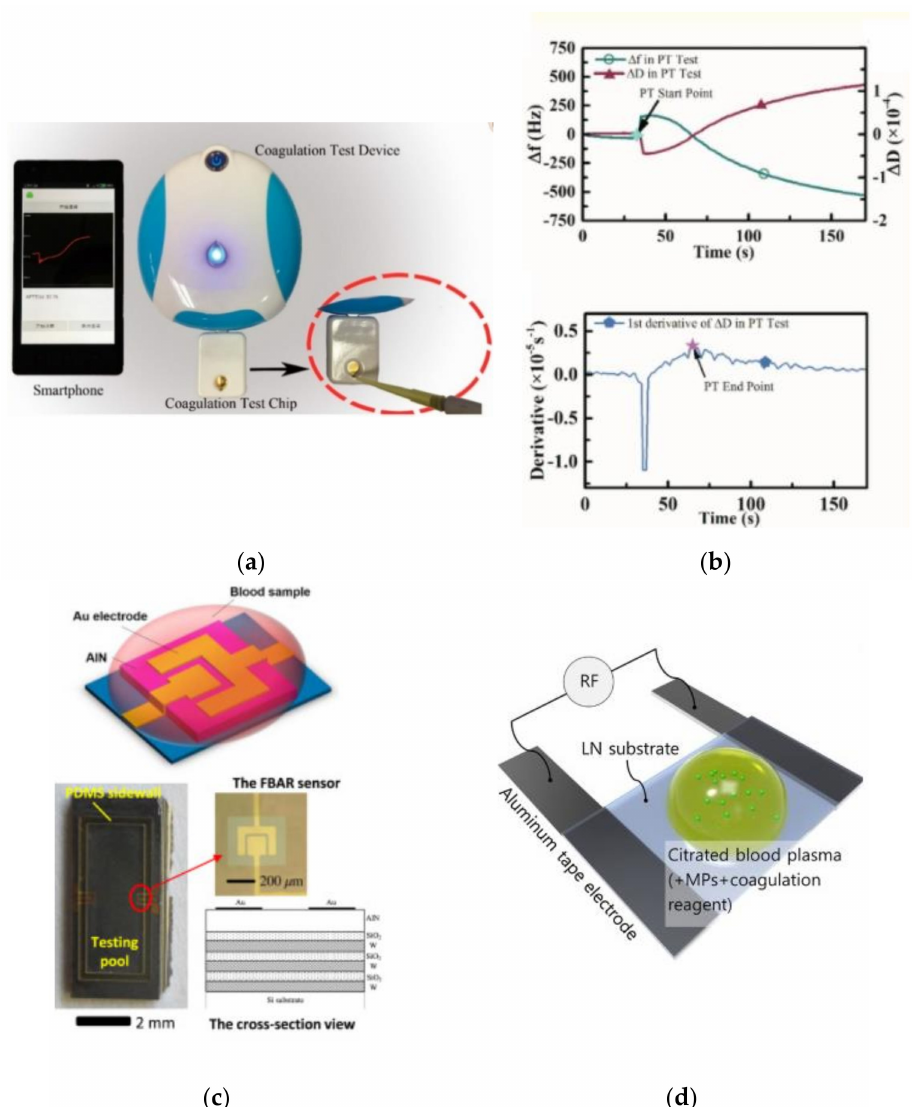
Figure 9. ( a ) Photograph of the smartphone/Bluetooth-based coagulation testing platform using quartz crystal microbalance dissipation method [61]. ( b ) Typical frequency and dissipation curves during PT measurements. (Reprinted with permission from ref. [61]). ( c ) Illustration and the microphotographs of the FBAR device. (Reprinted with permission from ref.